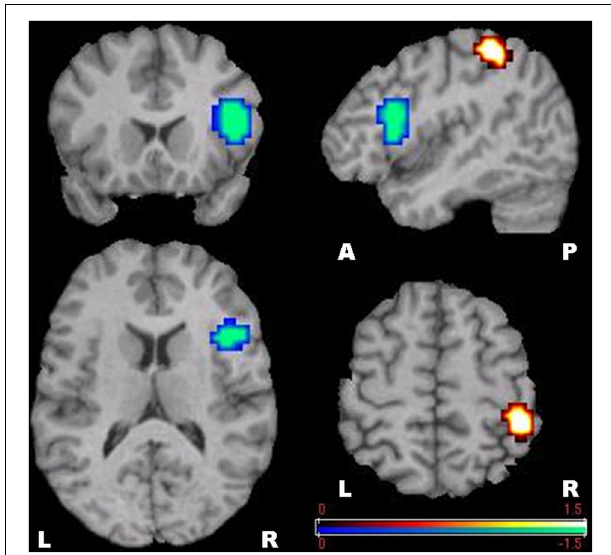
FIGURE 5 | SAM-permutation images of source power changes in the gamma (30–60Hz) band. Responses were calculated for the mental calculation (active state) vs. non-arithmetic condition (control state). Event-related synchronization was seen in the right posterior parietal cortex, and event-related desynchronization in the right inferior frontal gyrus. The color bar represents pseudo- t -values. L, Left; R, Right; A, Anterior; P,